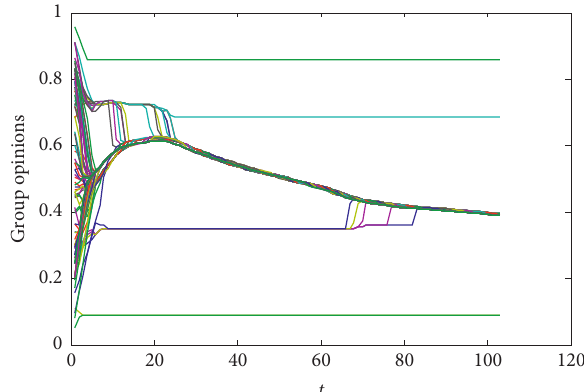
Figure 1: Asymmetry and complexity of the evolution in het- erogeneous